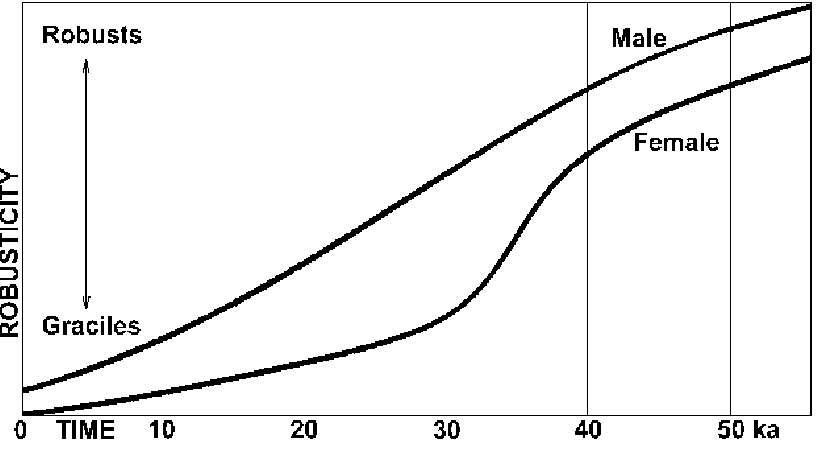
Figure 7. Schematic depiction of average male and female relative cranial gracility in Europe through time, showing that the decline in robusticity is gradual in males, but accelerated in females between 40 and 30